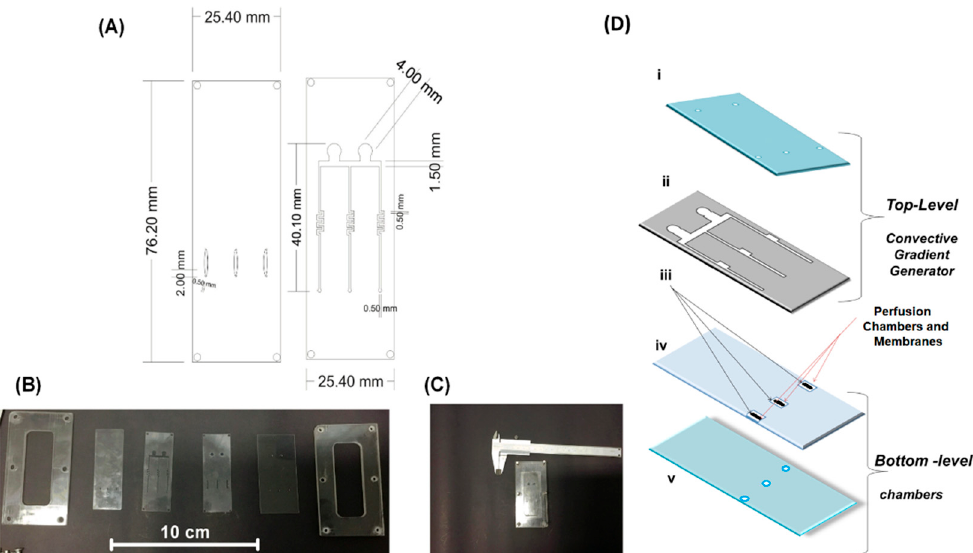
Figure 1. ( A ) Project of the two poly(dimethylsiloxane), PDMS, layers of the microfermentor; ( B ) layers and acrylic molds before the fermentor assembly; ( C ) microfermentor before the insertion and sealing of the optical fibers; ( D ) schematic diagram of the microfermentor: top-level (i) cover (glass), and (ii) microchannels (PDMS laminated); and bottom-level (iii) membranes (polycarbonate), (iv) intermediate sheet with holes (PDMS laminated), and (v) base (glass).